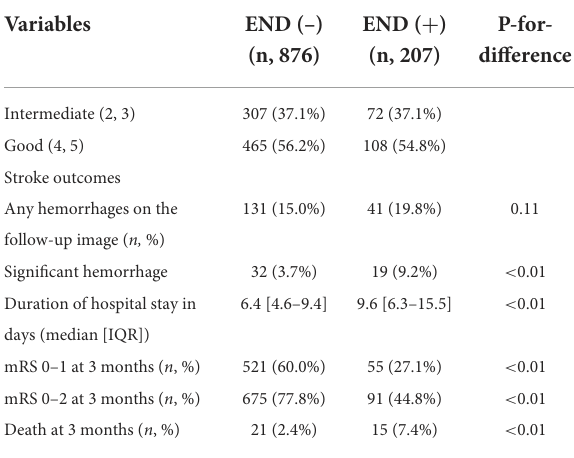
TABLE 3 Comparison of acute LVO patients with low NIHSS scores ( < 6) by early neurological deterioration